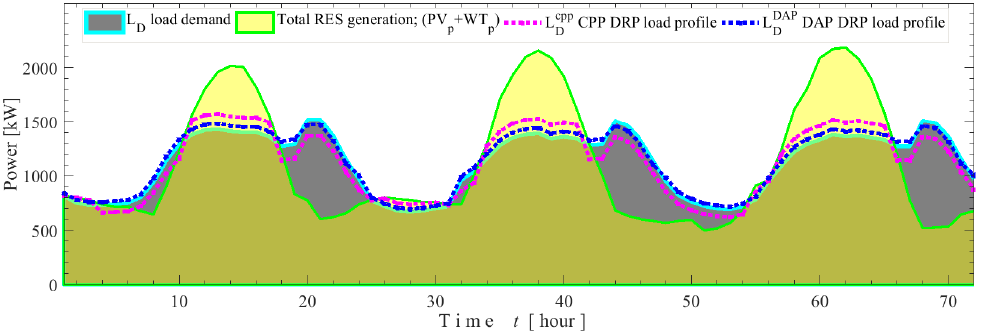
Figure 10. Role and impact of DRPs in minimizing the gap between total generated VRES power and load demand